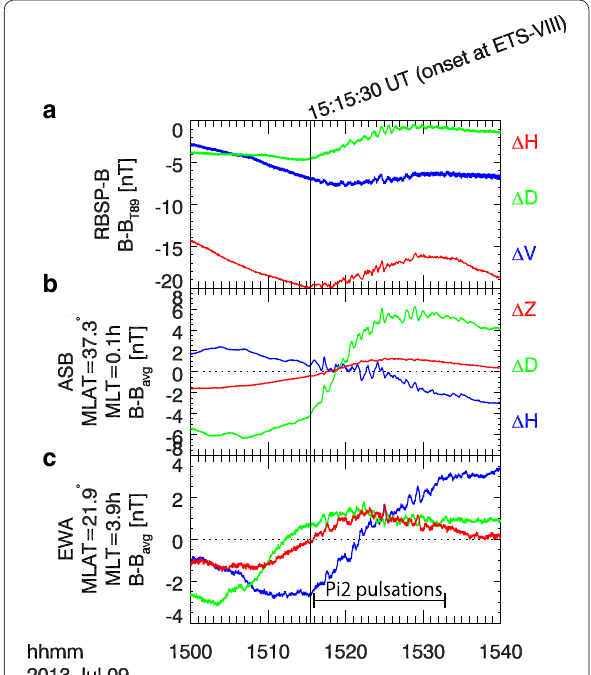
Fig. 3 Magnetic field data from a RBSP-B, b ASB, and c EWA. RBSP-B magnetic field data are subtracted by the Tsyganenko 89 model field at K p = 0 . The ground magnetic data are subtracted by each average on their values in the plotted interval. The horizontal bar shows the period when the Pi2 pulsations occurred